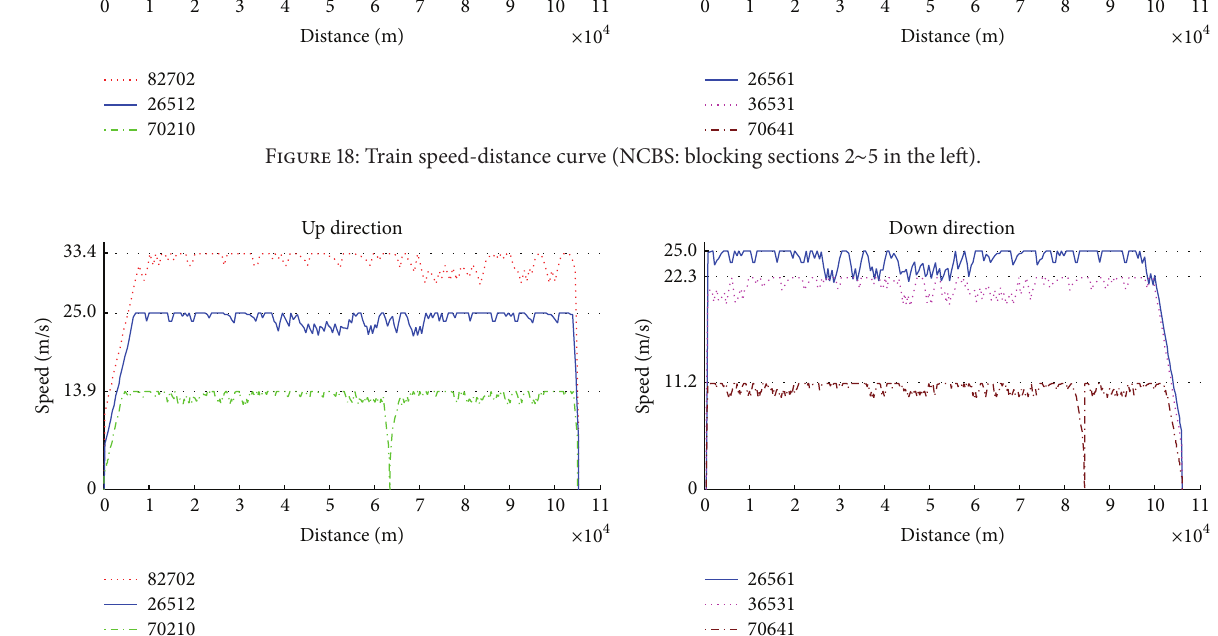
(S4) Fourth is continuous NCBSs including